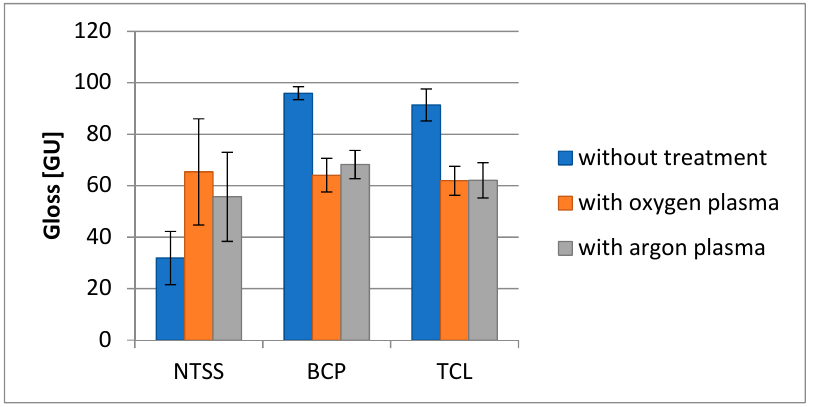
Figure 8. Changes in film gloss due to plasma activation.